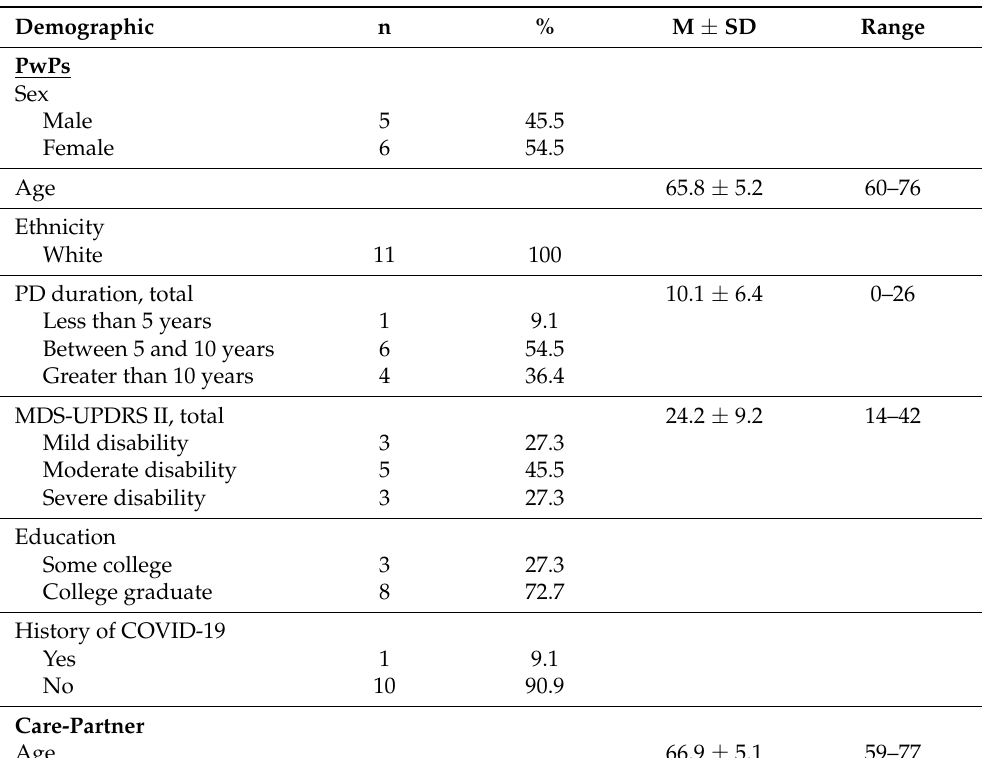
Table 2. Characteristics of PwPs and care-partners.